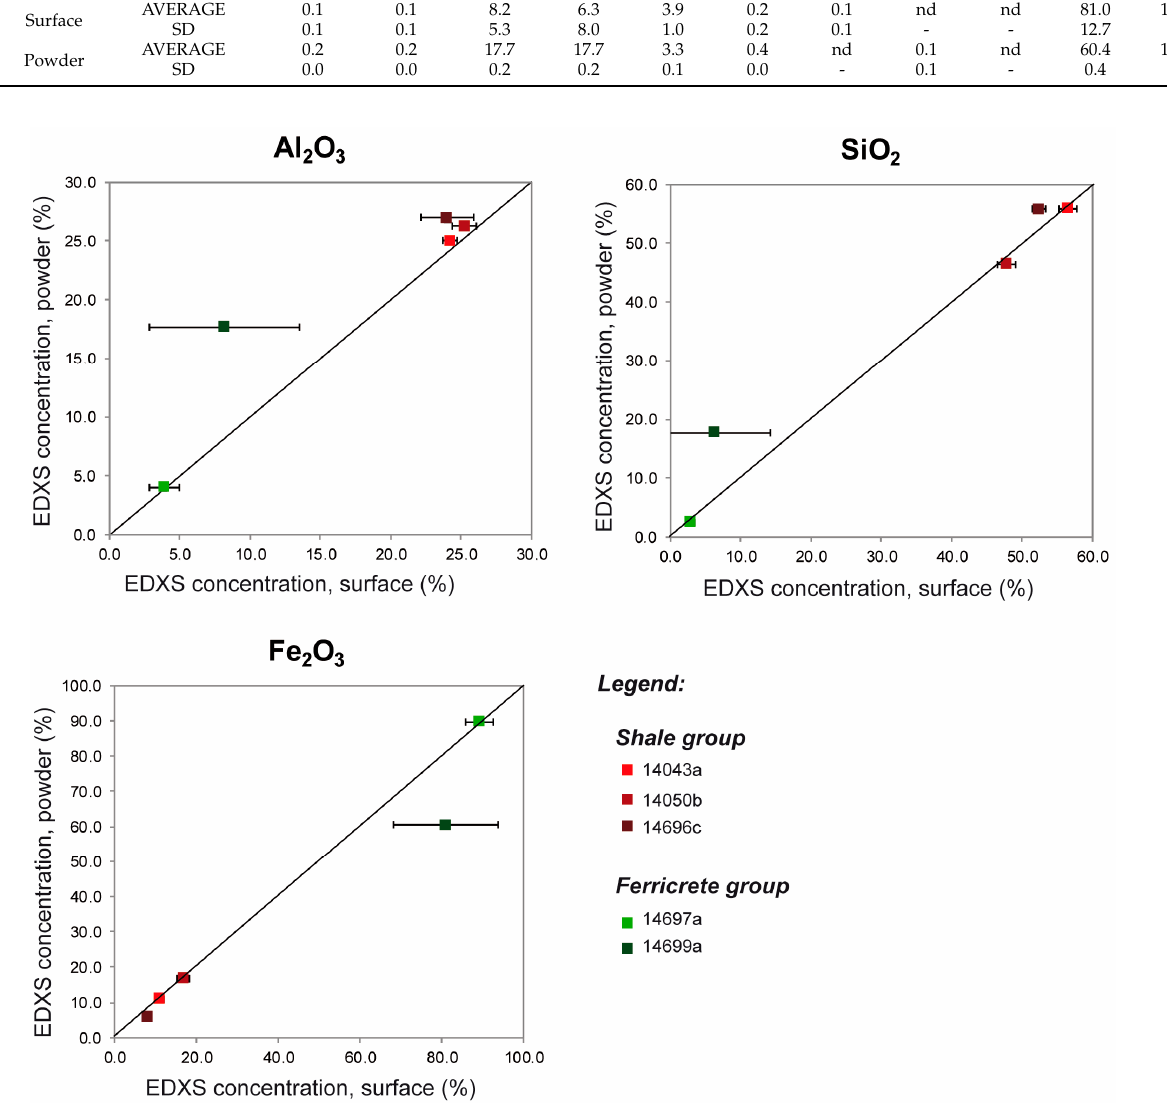
Figure 2. Results of EDXS analyses of cohesive geological pieces (surface) compared with the analysis of pellets (powder) for major elements Al, Si, and Fe.